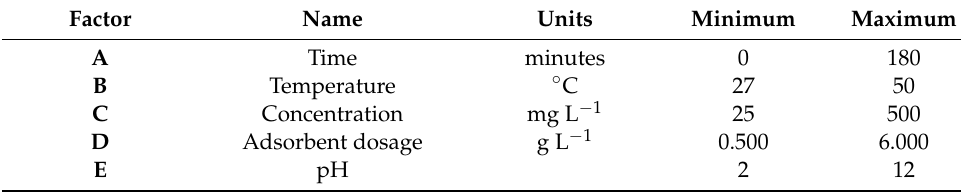
Table 3. Experimental design of individual factors for RSM